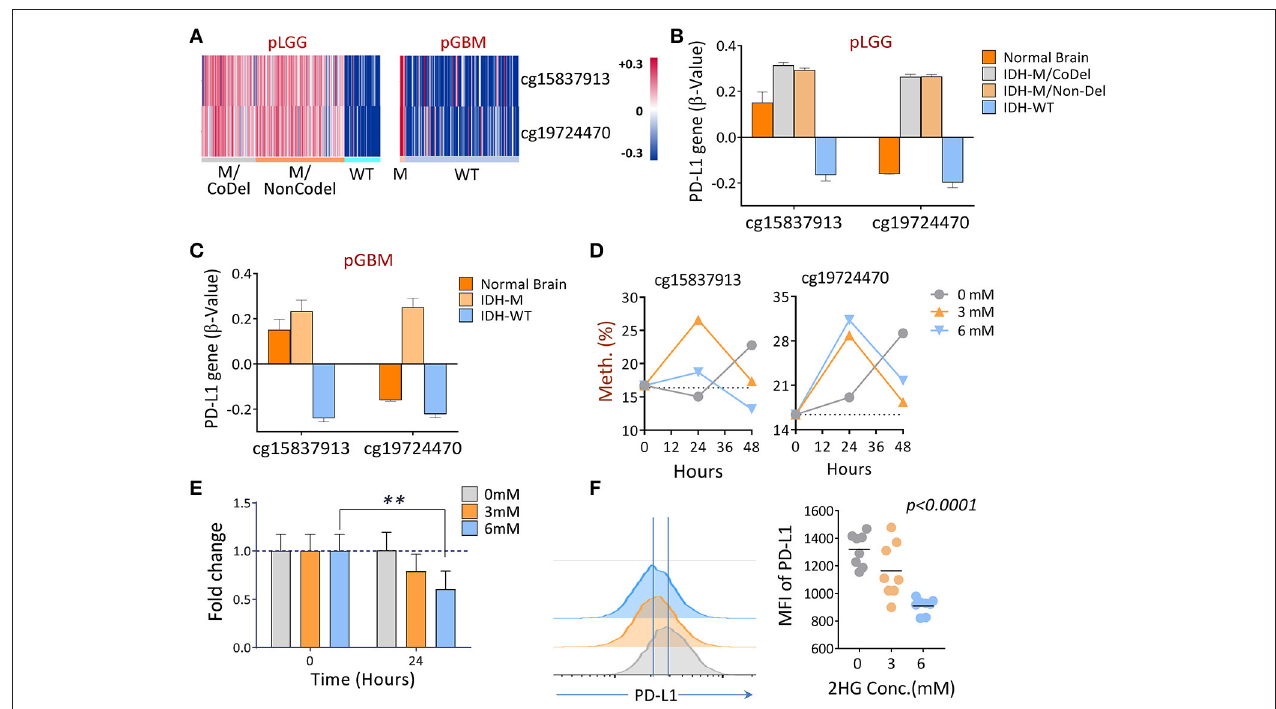
FIGURE 5 | The differential DNA methylation of PD-L1 between IDH1 mutant and wildtype tumors in primary gliomas. (A) Hierarchical cluster of DNA methylation (cg15837913, cg19724470) measured by the β -values between IDH1 mutant and wildtype tumors is shown. (B,C) Quantitative β -values in different subgroups of primary gliomas. DNA methylation and IDH mutation/1p/19q codeletion information of primary LGG and GBM patients were derived from a TCGA Human Methylation 450k Array, as well as using the supplementary data from a previous publication (Suzuki et al., 2015). The β -values of each methylation probe were already offset by − 0.5. (D) Adding 2-HG in vitro increased the DNA methylations of PD-L1. U87, an IDH wildtype, and a PD-L1-positive GBM line was cultured in medium containing indicated concentrations of 2HG, and the DNA was isolated at 24 and 48h, respectively; the levels of methylation at baseline and 24h were determined by pyrosequencing. (E,F) Adding 2HG transiently reduced gene (24h) and protein (48h) expression of PD-L1. The same cells described in (D) were also prepared for mRNA-qPCR and FACS analysis, and the experiments were repeated three times. The difference was determined using paired t